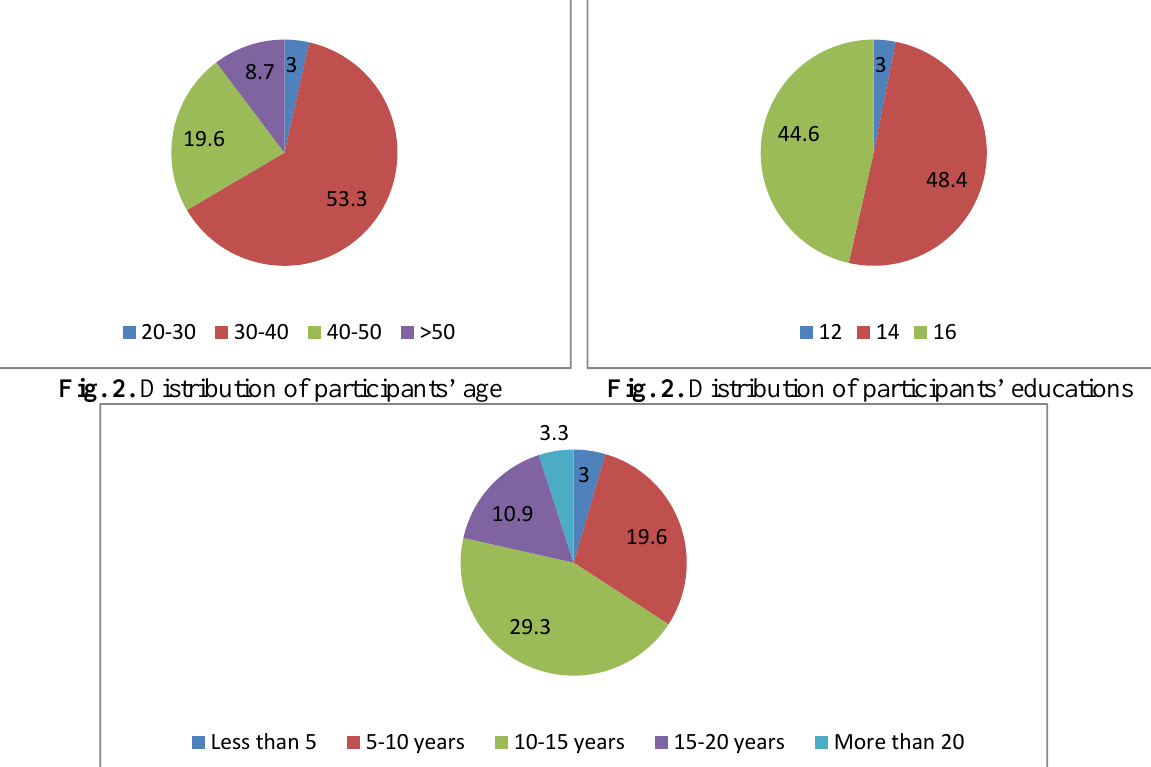
Fig. 2. Distribution of participants’ age Fig. 2. Distribution of participants’ educations